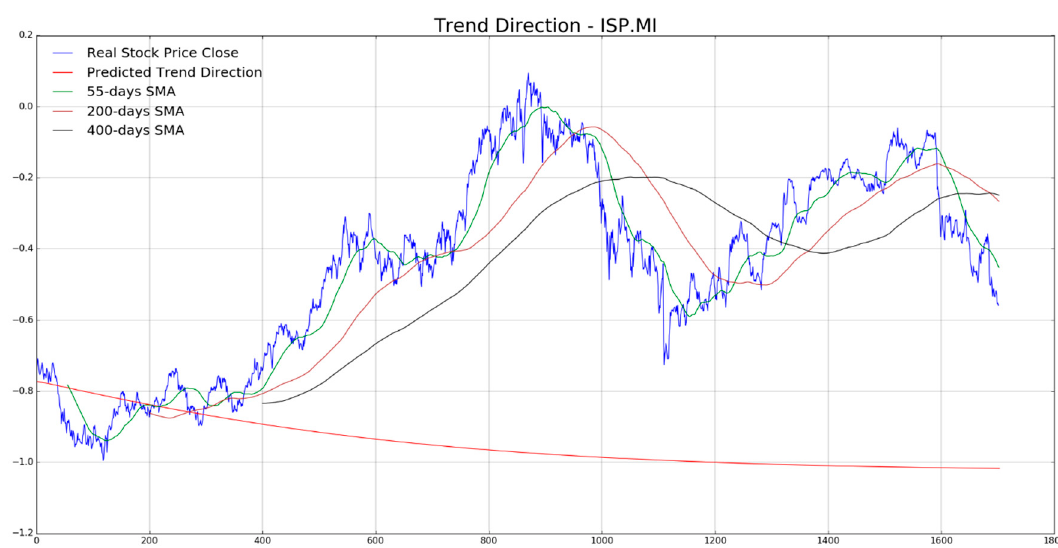
Figure 10. ISP.MI Trend Direction (red) and SMA.